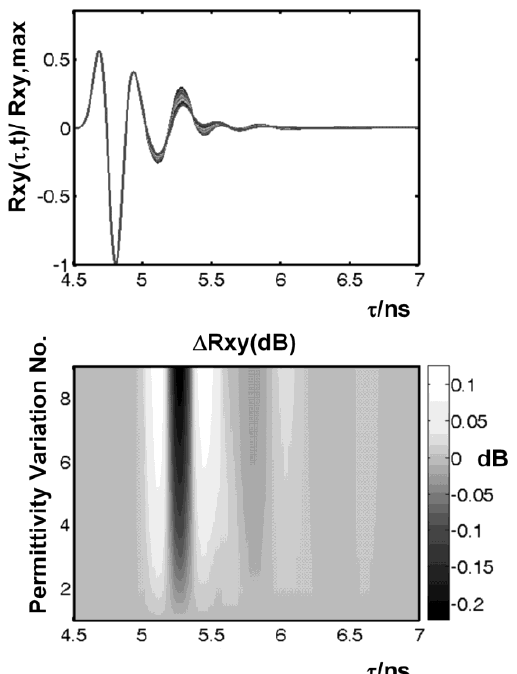
Figure 13. Top : correlation results R properties (nine different frequency courses, steps). Bottom : overlapped variation  R (  ,  ), i = 1,…,9. xy i